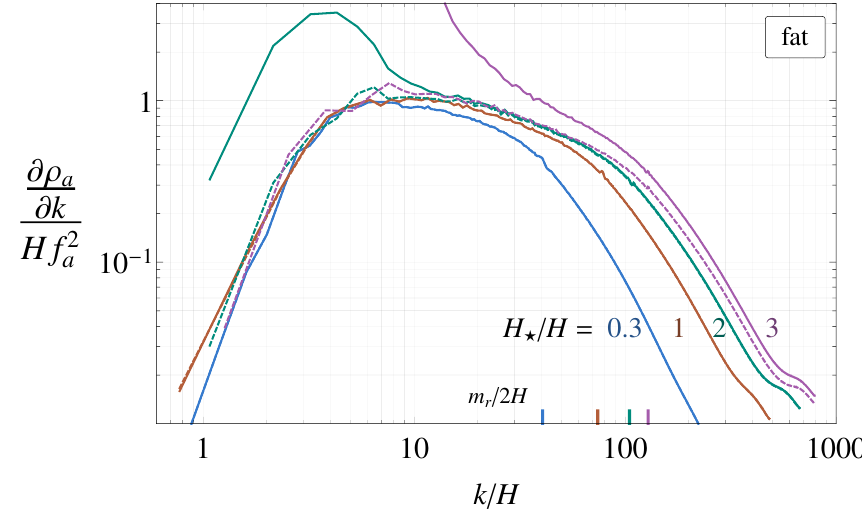
Figure 22: The evolution of the axion spectrum in the presence of the axion mass with log (cid:63) = 5 and α = 6 (upper lines) at different times labeled by H (cid:63) / H , and for vanishing axion mass (lower lines, dashed). Before H = H (cid:63) the non-zero axion mass has a negligible effect on the spectrum, but subsequently this gets modified starting starting from IR